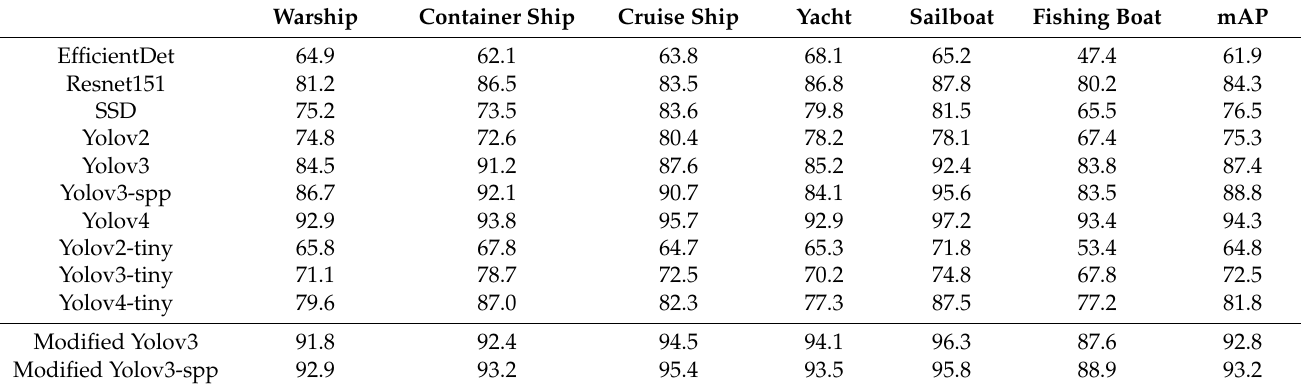
Table 5. Detection accuracy of the proposed modified methods and other networks on testing